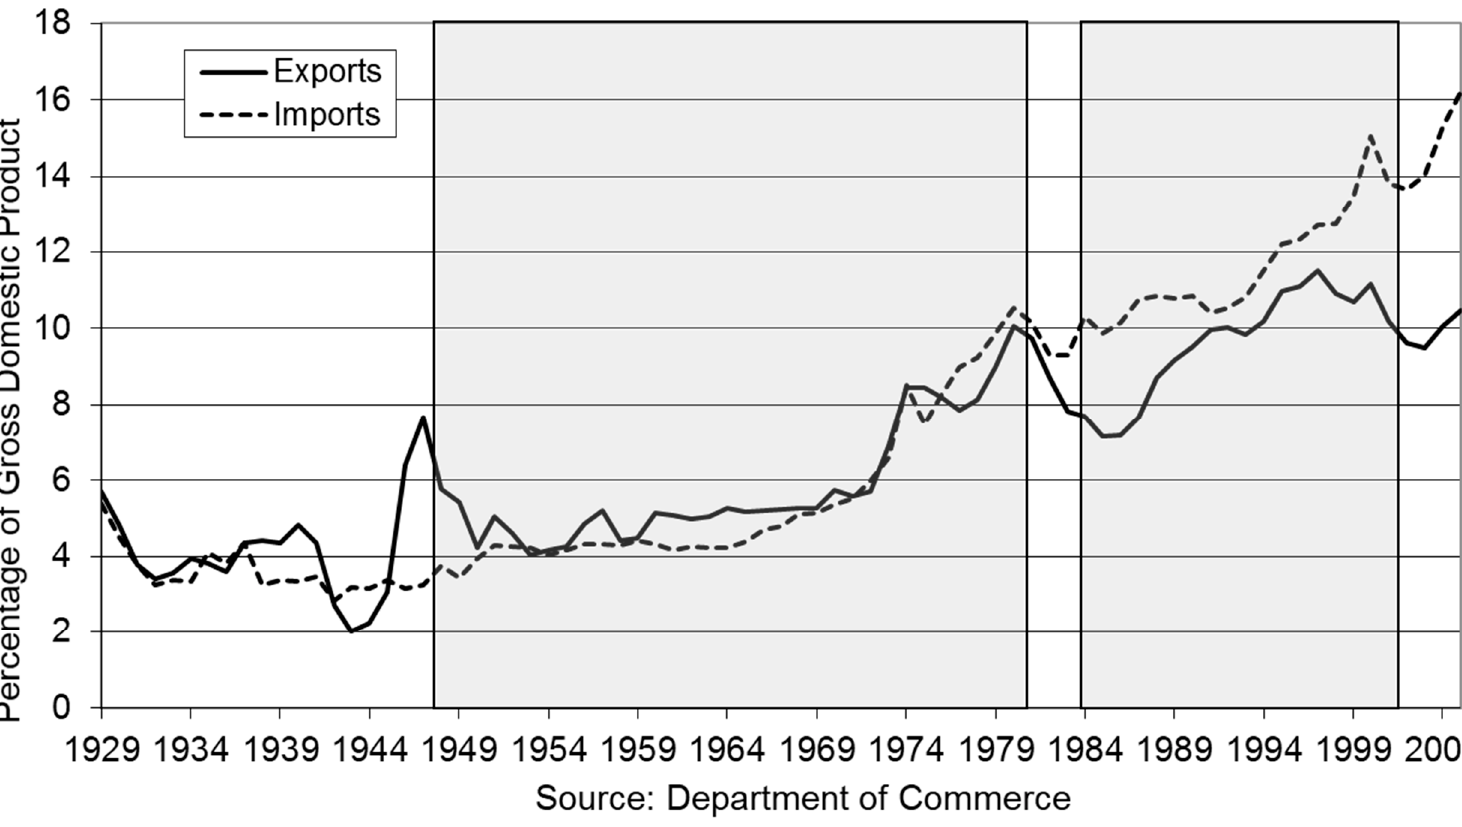
Figure 1. Trade and the American Economy.